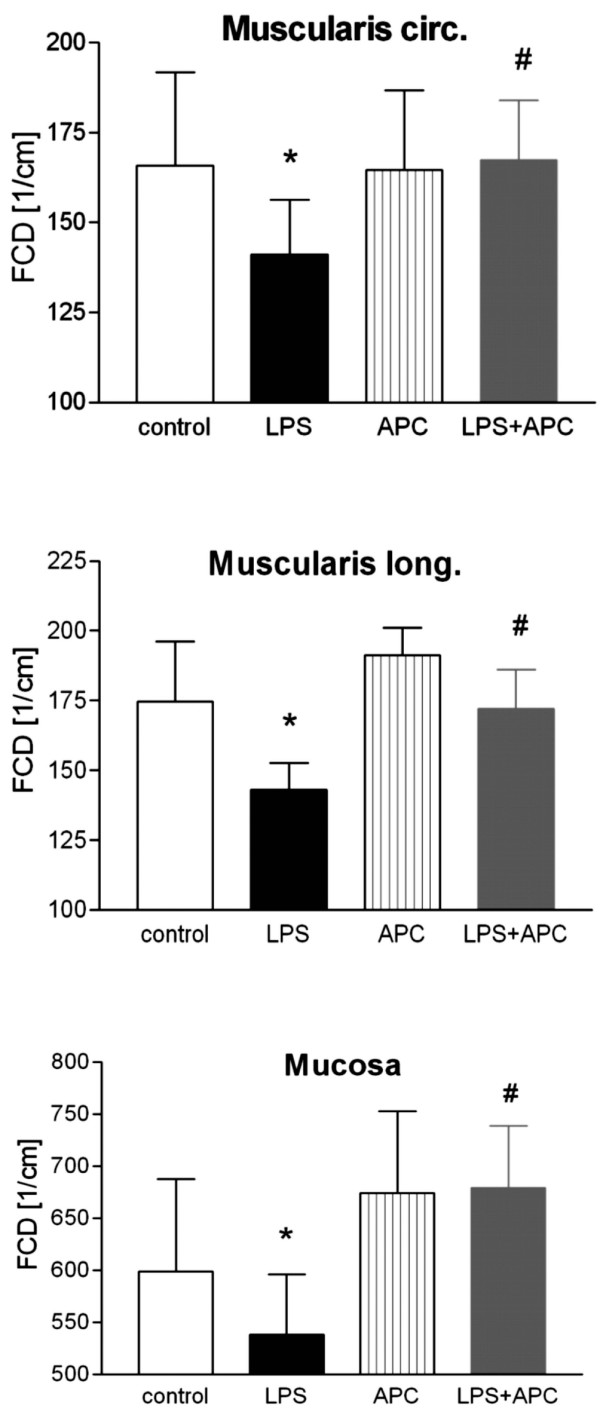
Functional capillary density (FCD) in the circular (a) and longitudinal (b) muscularis layer and in the mucosal layer (c). *p < 0.05 LPS versus control; #p < 0.05 versus LPS. APC, activated protein C-only group; LPS, lipopolysaccharide-only group; LPS + APC, activated protein C-treated endotoxaemic group.